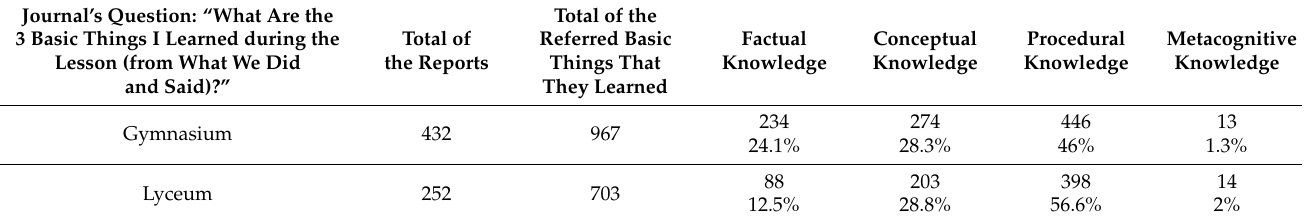
Table 6. The basic knowledge that students acquired in types of